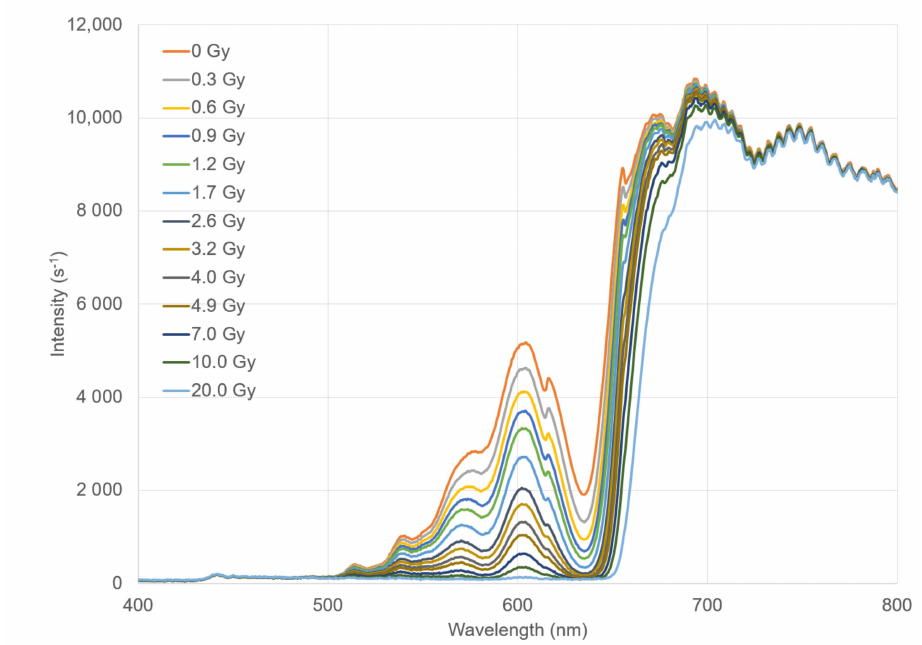
Figure 6. Spectral response of EBT3 (EBT = External Beam Therapy) Gafchromic™ films exposed to doses in the range 0–20 Gy. Adapted from Reference [86].